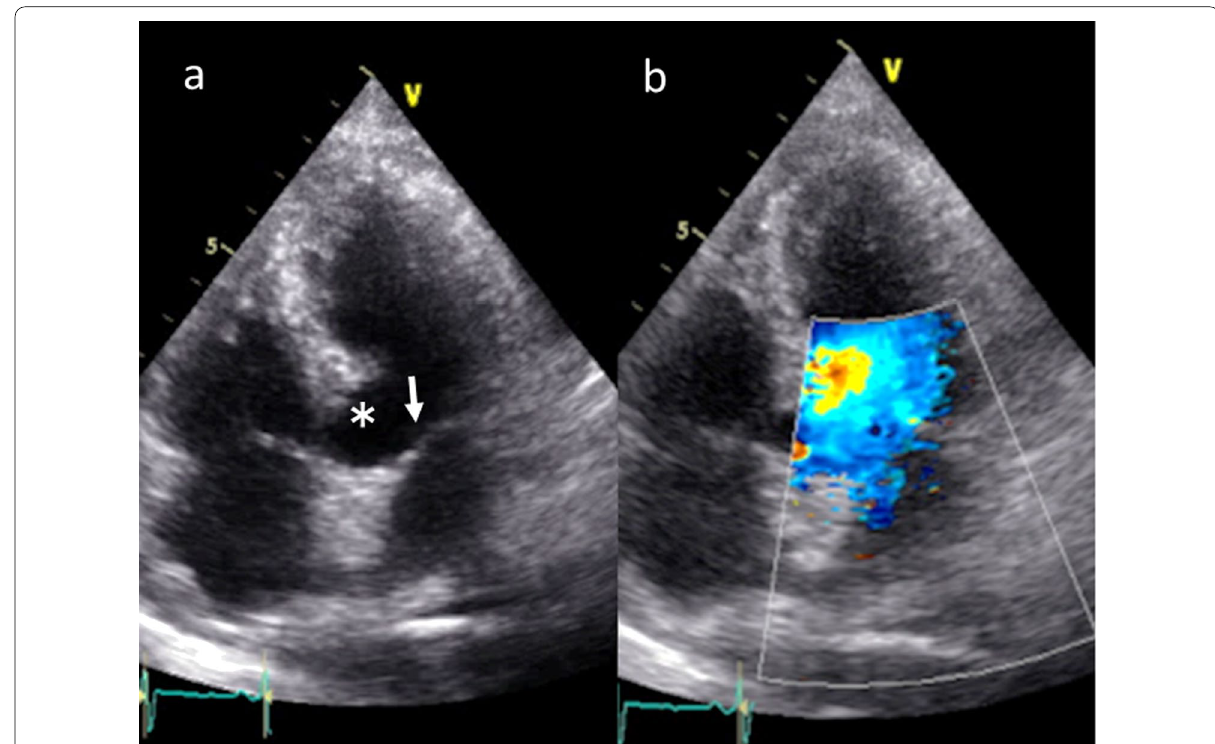
Fig. 4 Postoperative transthoracic echocardiographic views. a No evidence of systolic anterior motion (white arrow) and resected part of the basal interventricular septum (white asterisk). b Color Doppler imaging of no mitral regurgitation